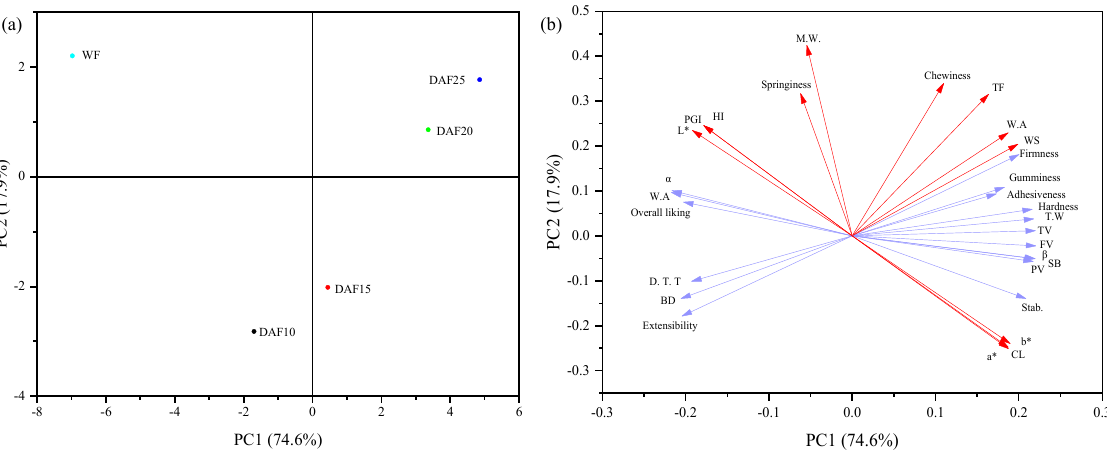
Figure 4. Score plot ( a ) and loading plot ( b ) of the first component (PC1) and the second component (PC2) describing the relationship of various flour, dough, and noodles characteristics. Samples nomenclature used is described above.